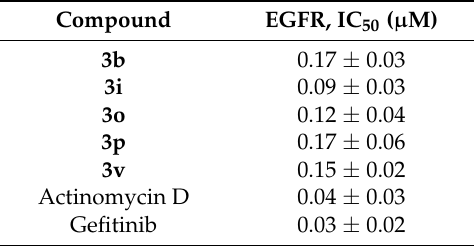
Table 5. IC 50 values (in µ M) of EGFR-TK by 3b 3i , 3o , 3p , and 3v against actinomycin D and